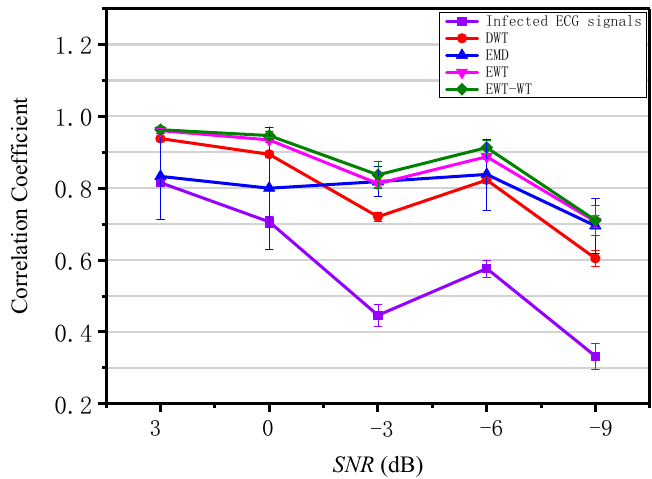
Figure 7. Comparison of correlation coefficient for EWT-WT with DWT, EMD and EWT.